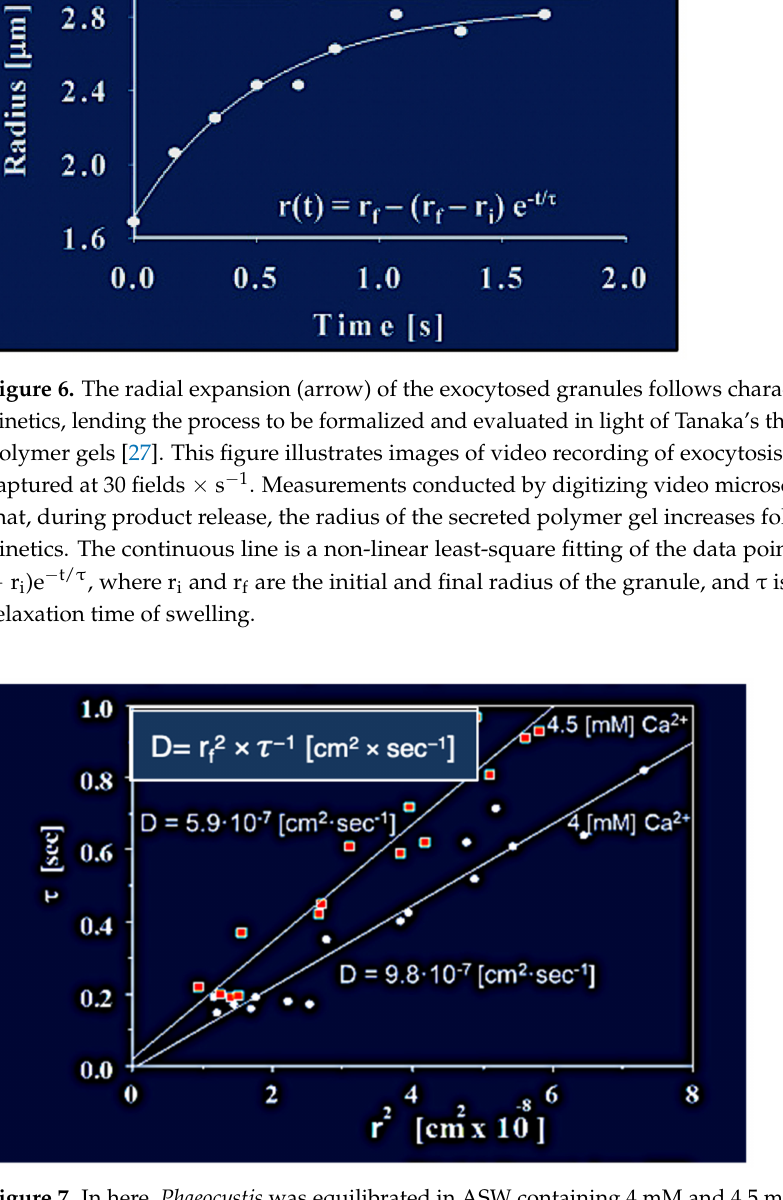
As expected, the effect of increasing [Ca 2+ ] in ASW illustrated in Figure 8, results in a power-law decrease of the diffusion of the exocytose Phaeocystis